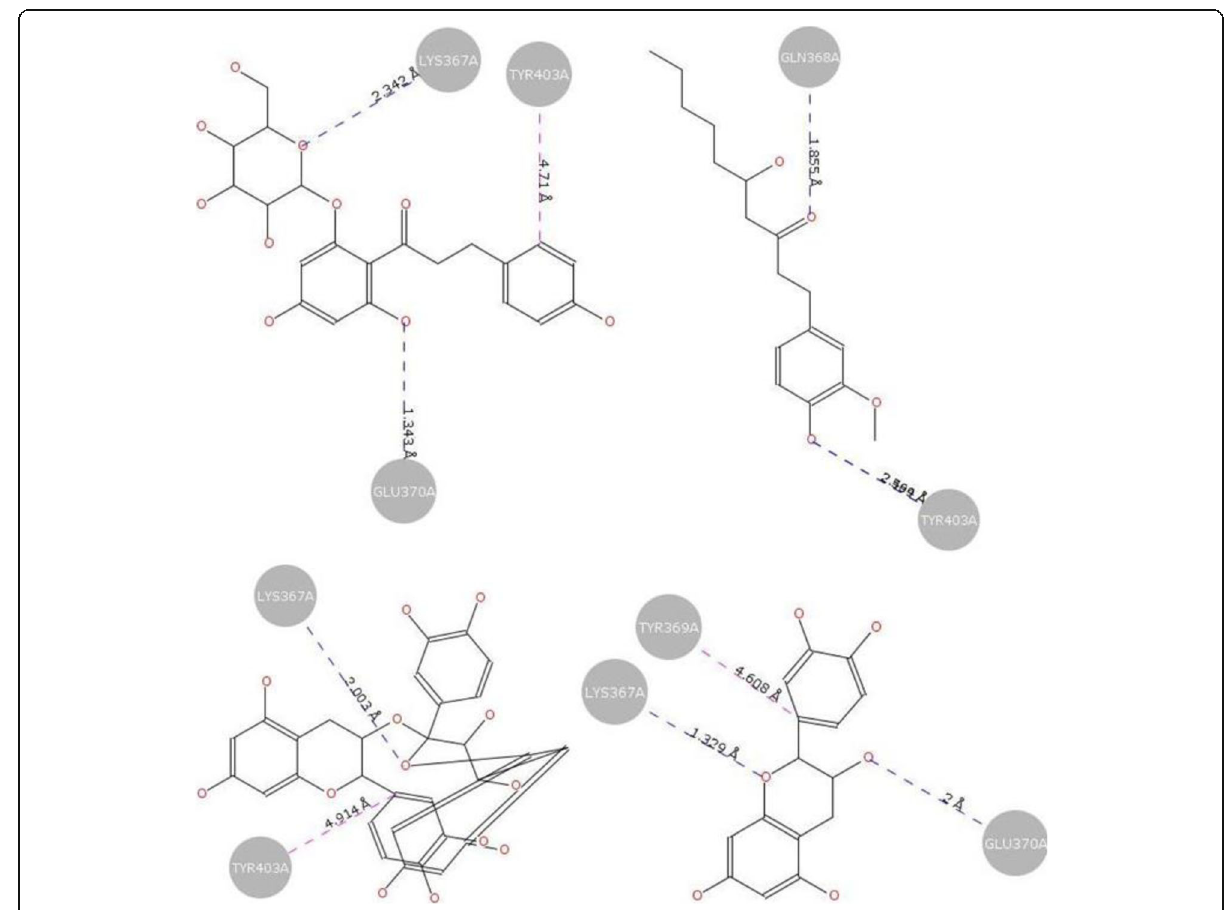
Fig. 7 Hydrogen bonding and aromatic interactions of phlorizin with cocrystallized ligand-tracked active site in 1N8S (top left). Hydrogen bonding of 6-gingerol with cocrystallized ligand-tracked active site in 1N8S (top right). Hydrogen bonding and aromatic interactions of procyanidin with cocrystallized ligand-tracked active site in 1N8S (bottom left). Hydrogen bonding and aromatic interactions of epicatechin with cocrystallized ligand-tracked active site in